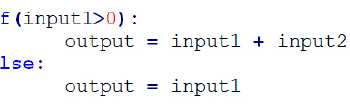
Figure 9. Example quantitative description of an output with two inputs